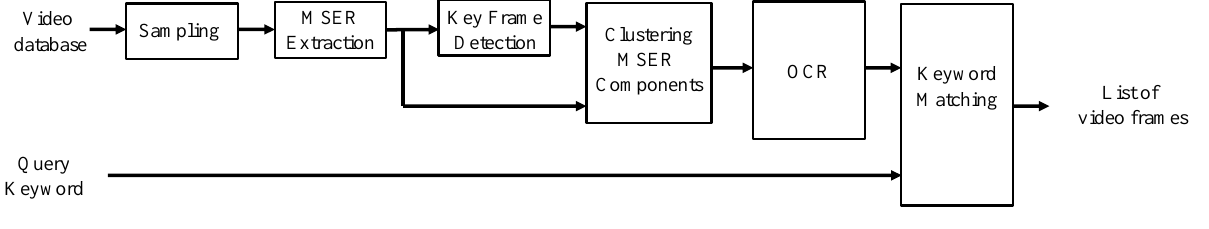
Figure 1. Overview of the proposed system.